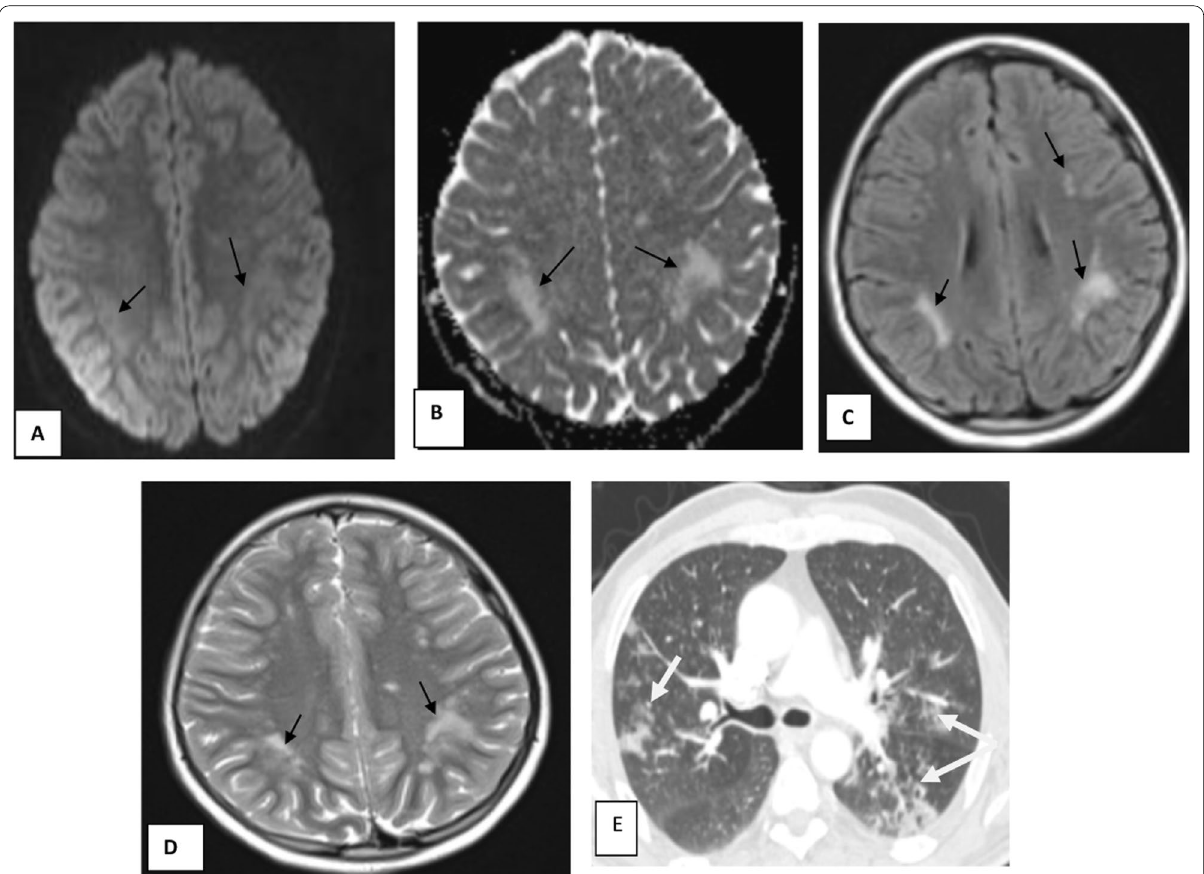
Fig. 9 Male patient aged 28 years old, with history of COVID‑19 infection. MRI of brain shows multiple patchy areas of abnormal signal intensity seen at subcortical white matter bilaterally (black arrows). They display high signal intensity in FLAIR and T2WI sequences ( C , D ), no diffusion restriction at DWI and ADC ( A , B ), no surrounding edema or mass effect. ADEM is considered in this case. Axial CT ( E ) chest cut of the same patient shows bilateral peripheral ground‑glass opacities (white arrows) (moderate